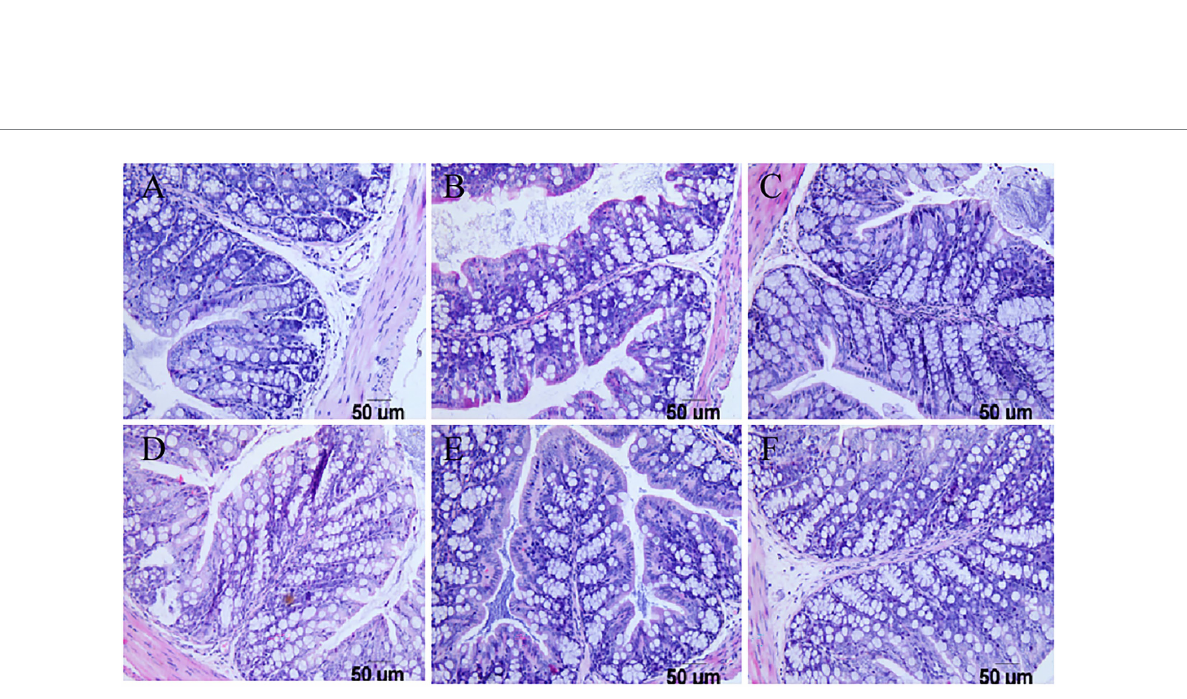
FIGURE 7 Pathological sections of the large intestine in mice. (A) Pathological sections of the large intestine in the PBS group. (B) Pathological sections of the large intestine in the challenge group. (C) Pathological sections of the large intestine in the antiviral drug group. (D) Pathological sections of the large intestine in the Pediococcus acidilactici group. (E) Pathological sections of the large intestine in the Lactobacillus casei group. (F) Pathological sections of the large intestine in the Lactobacillus paracasei